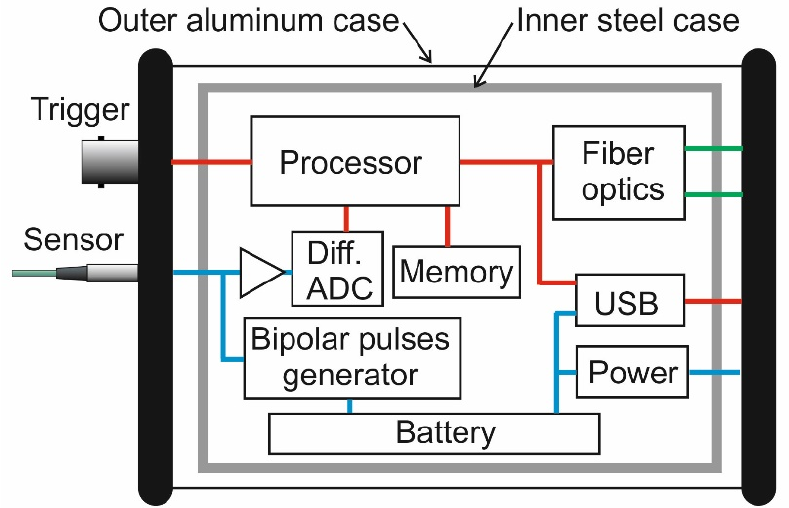
Figure 11. Main functional blocks of the fast B-scalar meter.